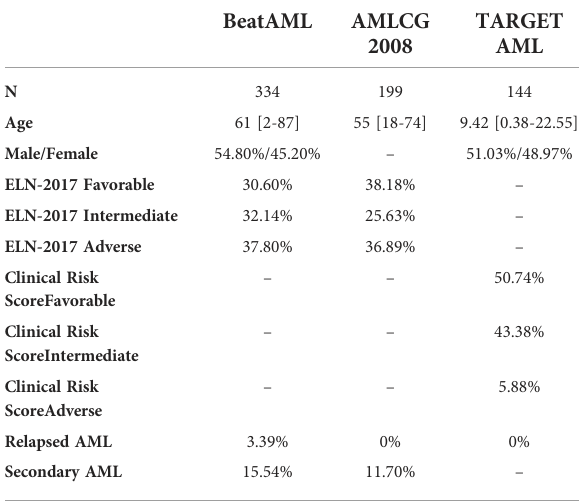
TABLE 2 Baseline Characteristics of patients included in the three